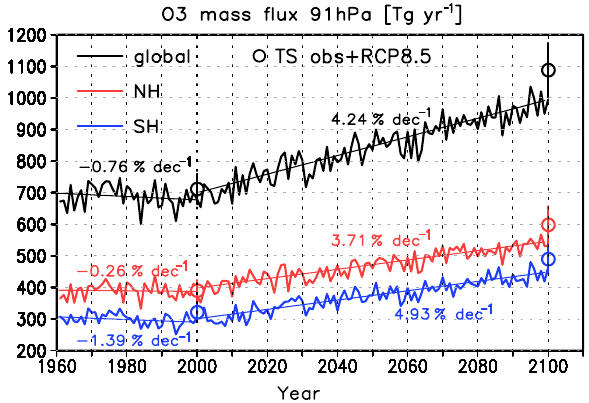
Figure 4. Temporal evolution of the ozone mass flux [Tgyear − 1 ] into the troposphere from 1960 to 2099 in the transient RCP6.0 sim- ulation integrated globally (black), over the Northern Hemisphere (red), and the Southern Hemisphere (blue). The thin lines indicate the linear fits for the sub-periods 1960 to 2000 and 2000 to 2099. In addition, the ozone mass fluxes derived from the time-slice sim- ulations (TS) for the years 2000 (REF2000) and 2100 (REF2100, RCP8.5 scenario) are shown by open circles including the ± 2 σ